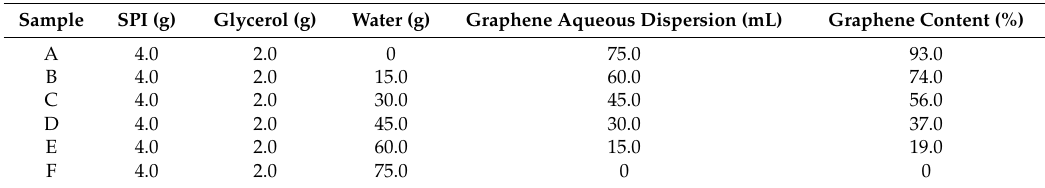
Table 1. The composition parts of graphene–SPI